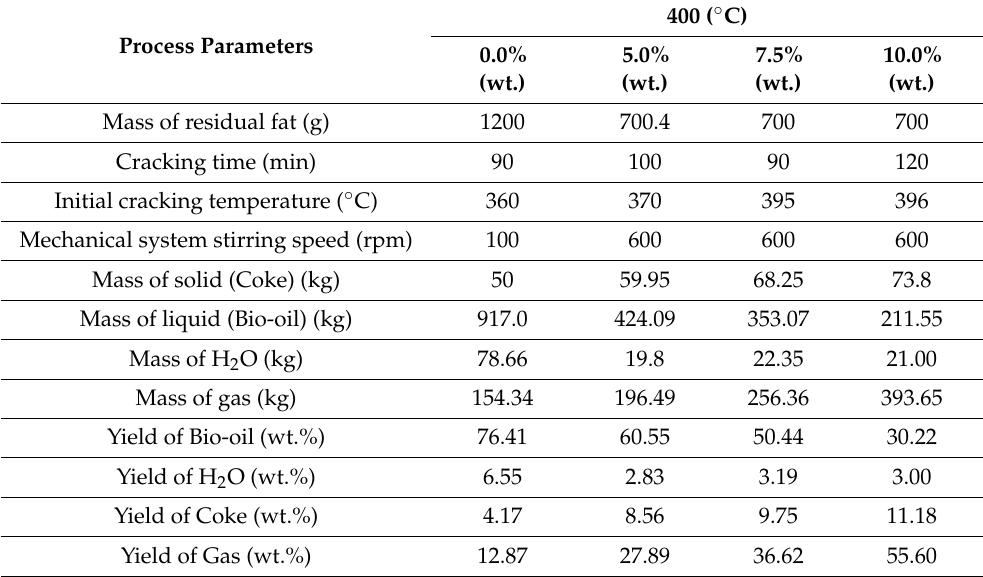
Table 3. Process parameters, mass balances, and yields of reaction products (liquids, solids, H 2 O, and gas) by catalytic upgrading of residual fat pyrolysis vapors at 400 ◦ C, 1.0 atm, 0.0%, 5.0%, 7.5%, and 10.0% (wt.) activated carbon pellets impregnated with 10.0 M NaOH, using a catalyst fixed-bed reactor, in semi-pilot